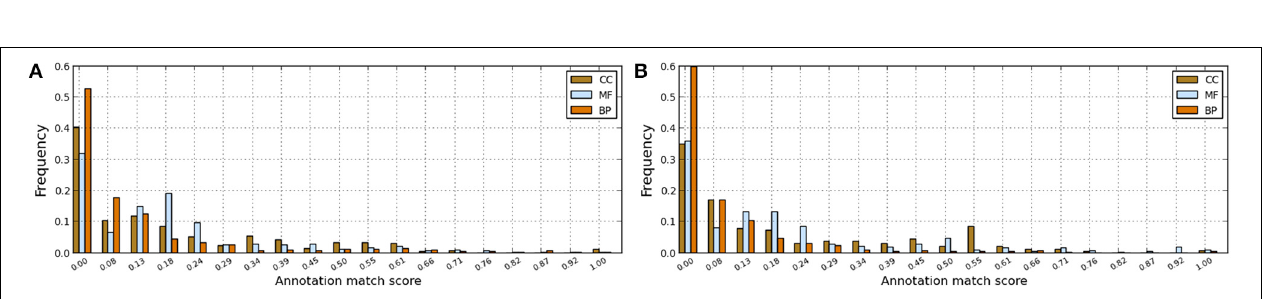
FIGURE 3 | Annotation matches between manual and electronic pipelines for human and fruitfly genomes with scores computed using the GO-universal metric. (A) Human genome. (B) Fruitfly